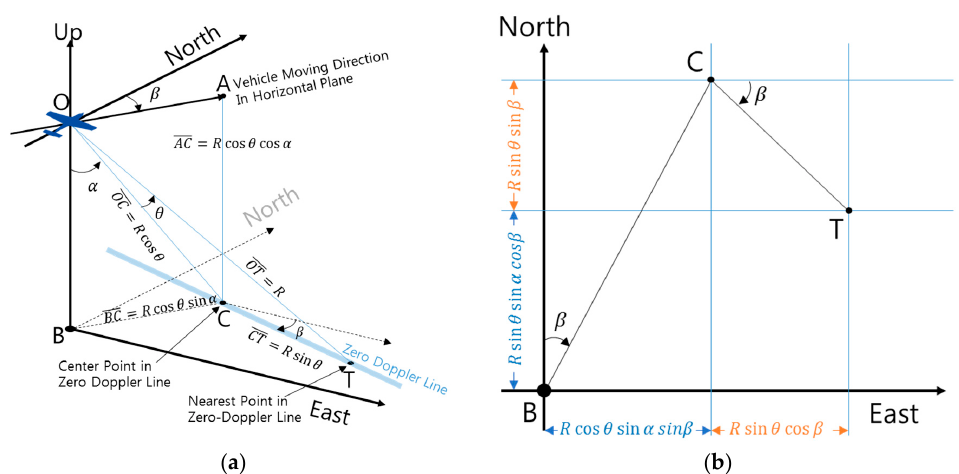
Figure 10. Relative position from aircraft to closest point: ( a ) 3-dimensional graph; ( b ) 2-dimensional graph [12].